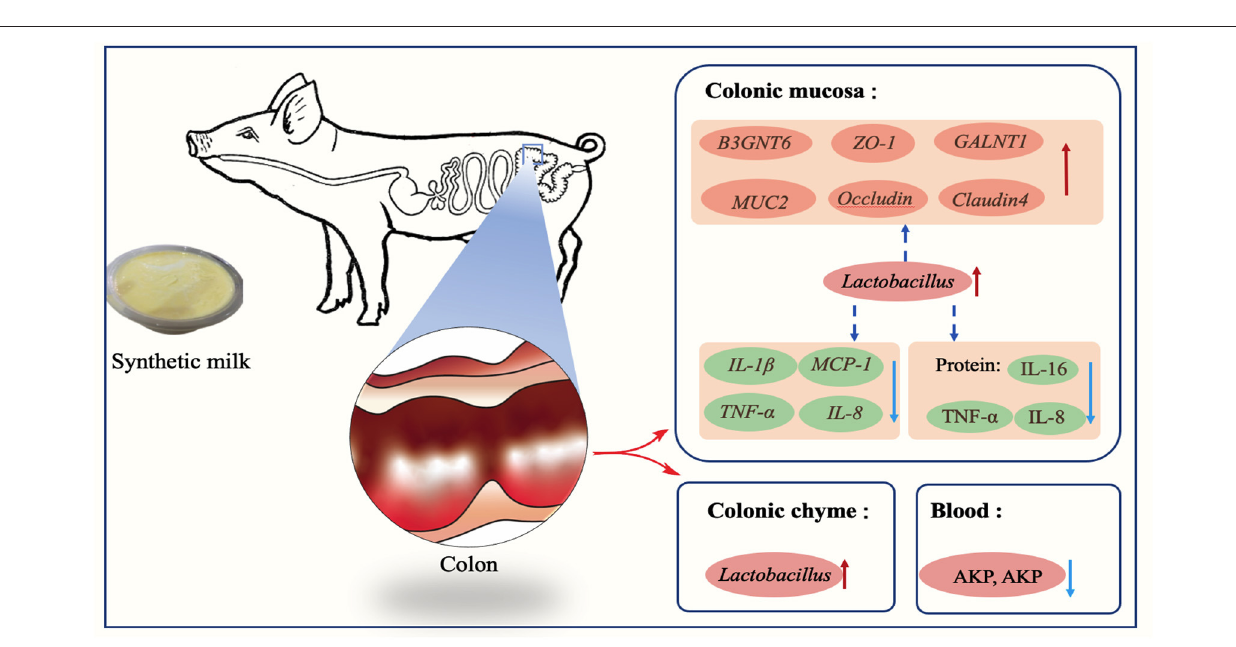
interventions. Lactobacillus was enriched in colonic mucosa and chyme of piglets. These findings indicate that early-life nutrition interventions supported growth of beneficial bacteria in the